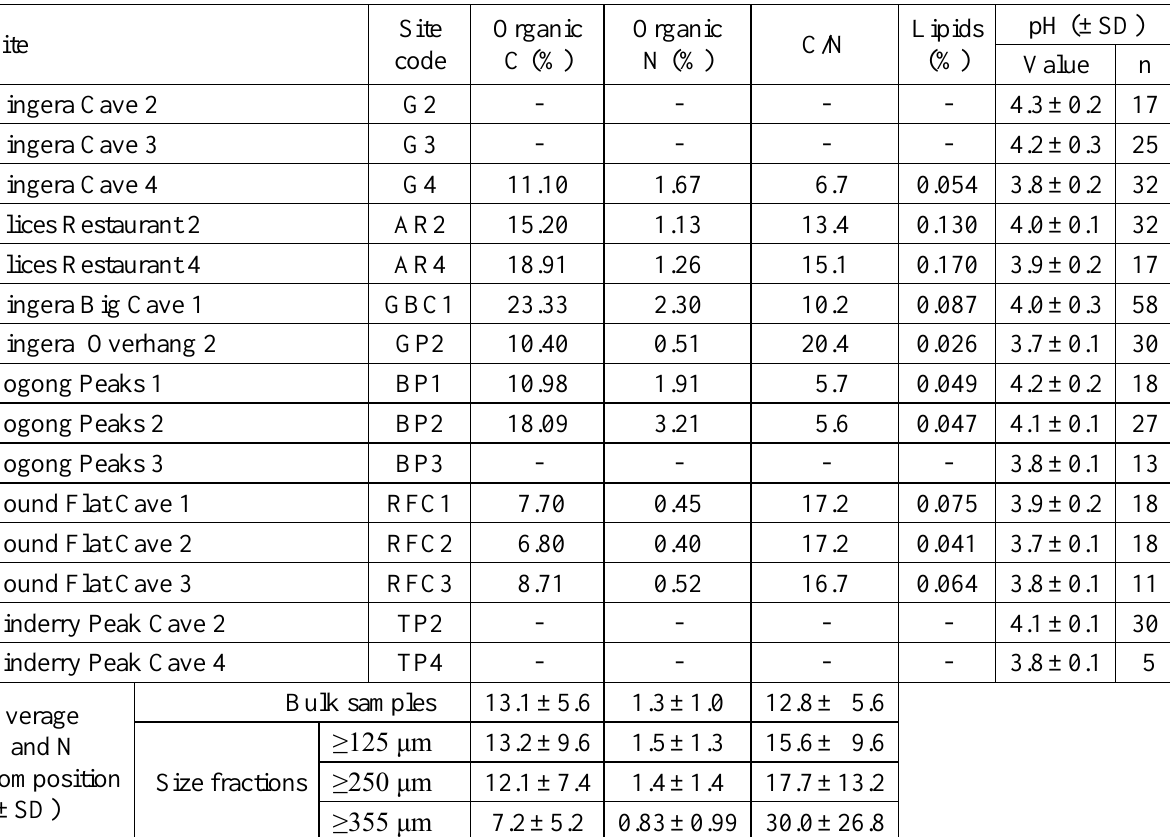
Table 2. Carbon (C), nitrogen (N) and lipid contents (dry weight basis) plus acidity (pH) for peat profiles at aestivation sites. SD = standard deviation, n = number of